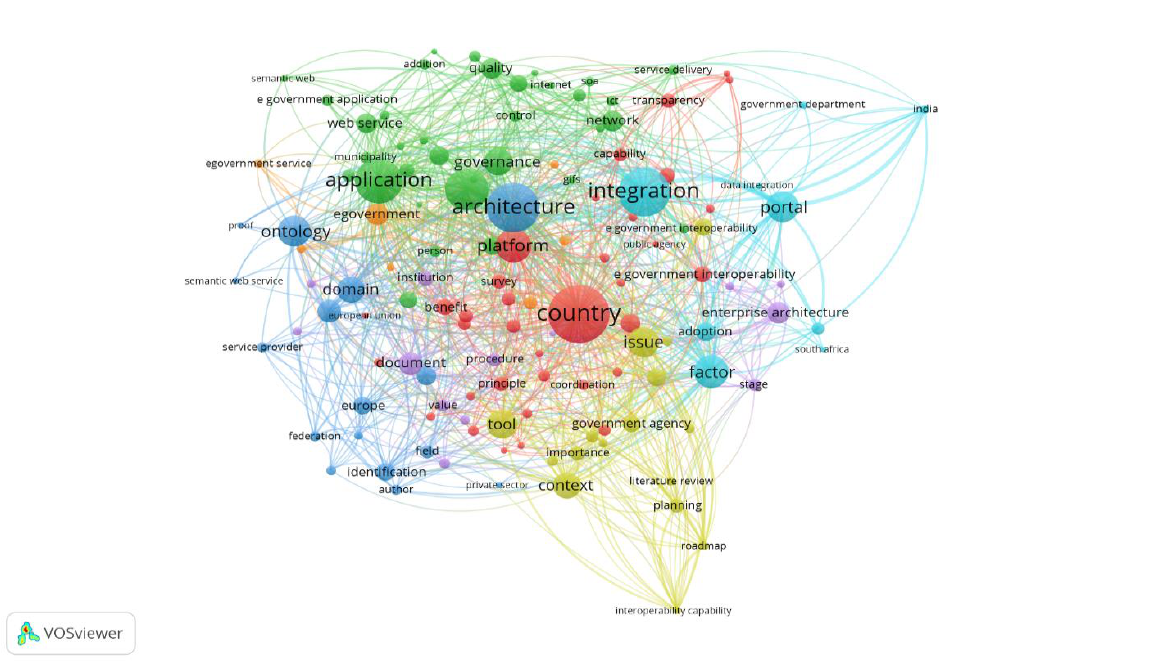
Figure 6: Networks Visualisation interoperability E-Government. Source: Processed by the author using Vosviewer.